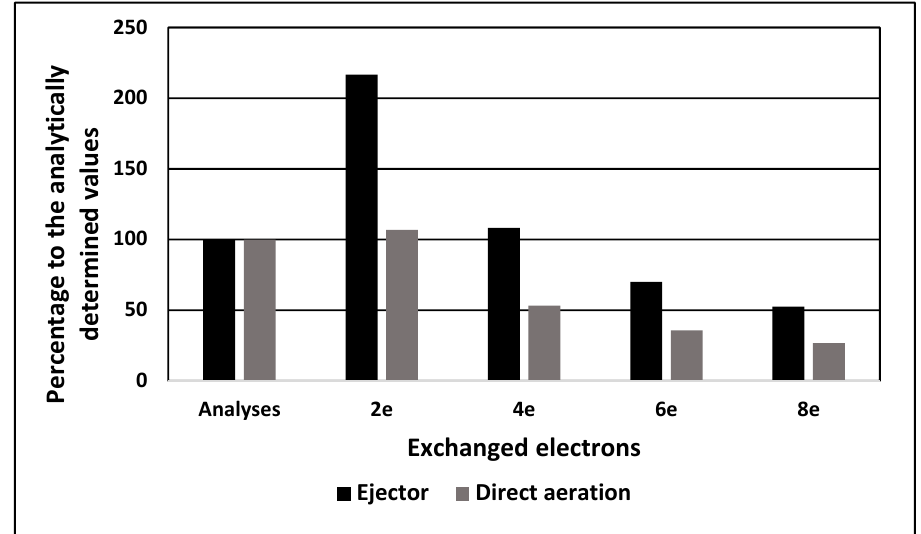
Figure 7. Ratios of the sulfide conversion rates calculated by Faraday’s law to the analytically determined ones (as 100%). Two types of aeration. Experimental conditions of run 5, Table S1.